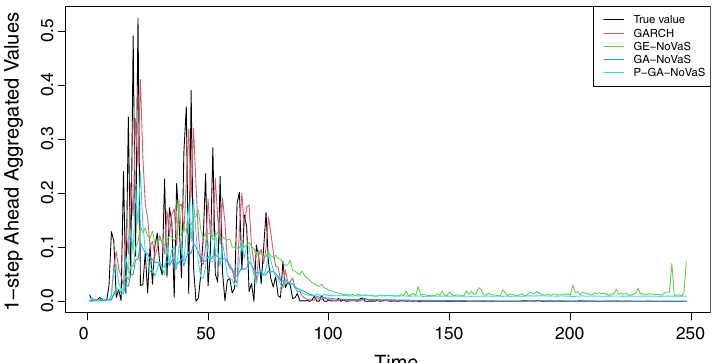
Fig. 2 The curves of different methods’ 1-step ahead aggregated predictions on 500 simulated Model 8 data and actual